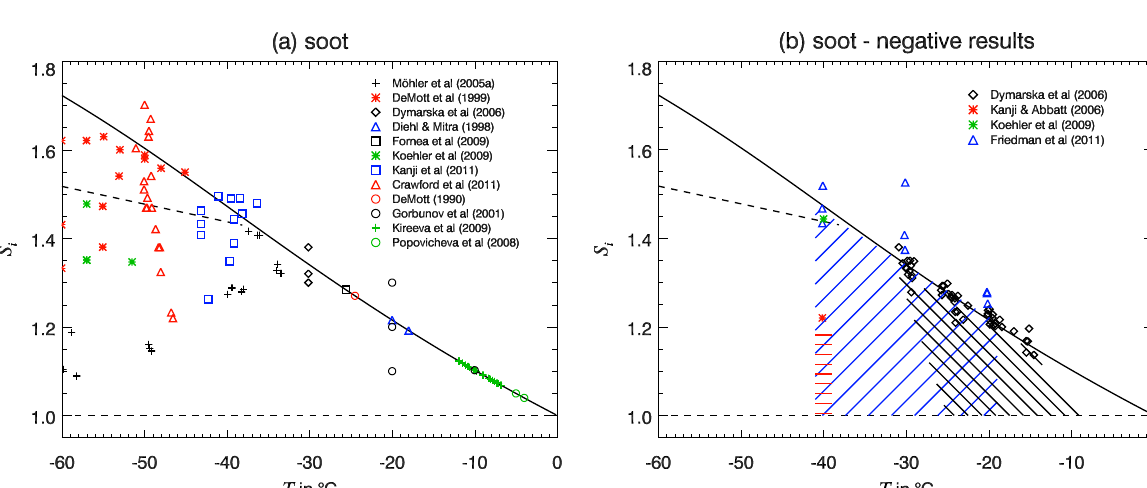
Fig. 4. (a) Ice nucleation onset temperatures and saturation ratios for soot. (b) Conditions under which ice nucleation on soot particles was not found or could not be distinguished from nucleation on the substrate. The dashed areas indicate the range of conditions which have been probed during the experimental trajectories to the indicated